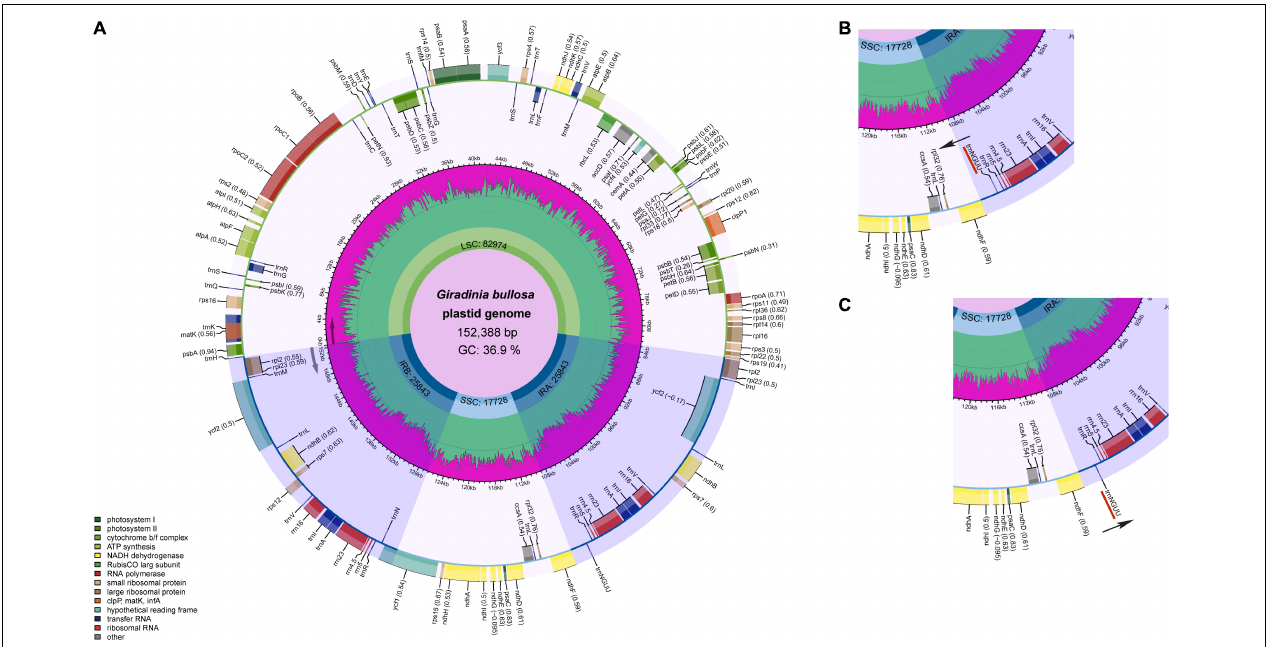
FIGURE 2 | (A) Gene map of complete chloroplast genome of Girardinia bullosa (a typical representative of gene organization in Urticeae s.l. plastomes); (B) inset map showing the inverted orientation of trnN-GUU in clade 3C except for Discocnide mexicana ; (C) inset map of the Urticeae plastome, showing the typical orientation of trnN-GUU. Genes inside and outside the outer circle are transcribed clockwise and counterclockwise, respectively.